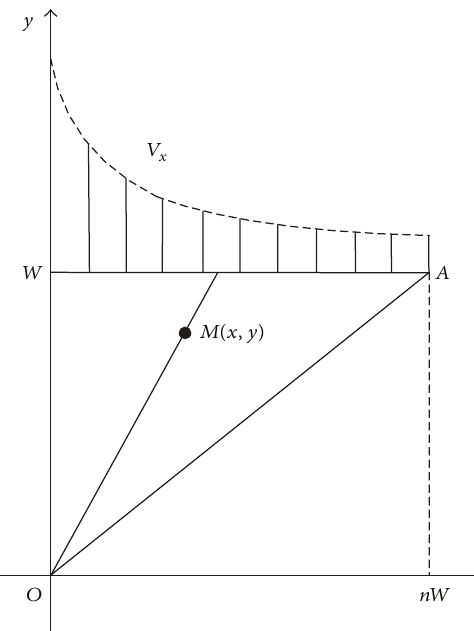
Figure 11: Distribution of ejection velocity of fragmented concrete